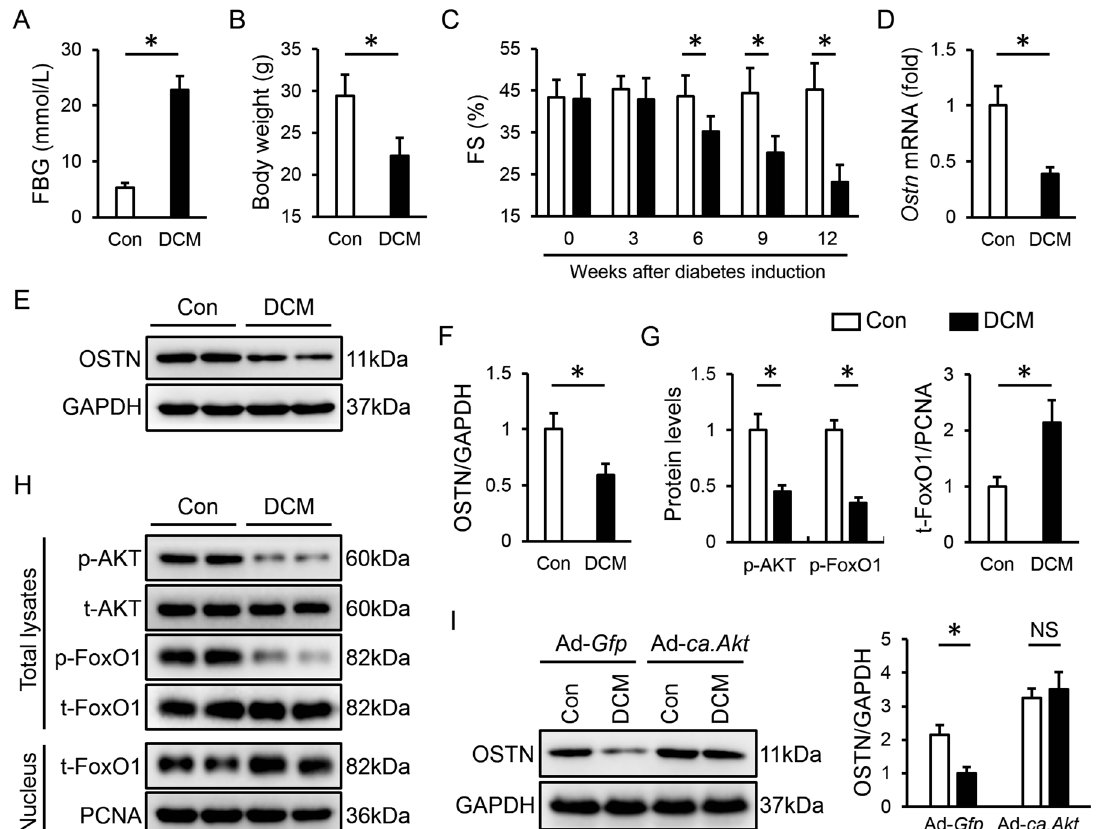
Fig. 1 OSTN is reduced by AKT/FoxO1 dephosphorylation in diabetic hearts. A FBG levels in mice at 12 weeks after diabetes induction ( n = 8). B Body weight in mice ( n = 8). C FS in mice ( n = 8). D Relative Ostn mRNA levels in diabetic hearts ( n = 6). E – I Representative western blot images and statistical results ( n = 6). Data represent mean ± SD. * P < 0.05 versus the matched group, NS indicates no signi fi